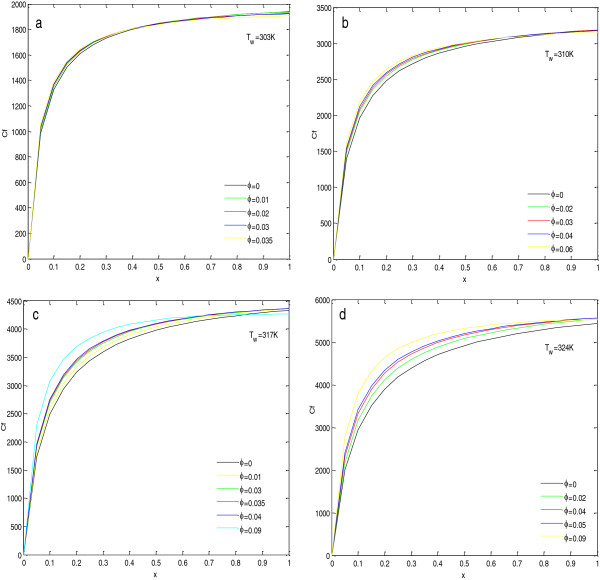
Local skin friction coefficient for Al2O3 + H2O nanofluid at(a,b,c,d)different wall temperatures.